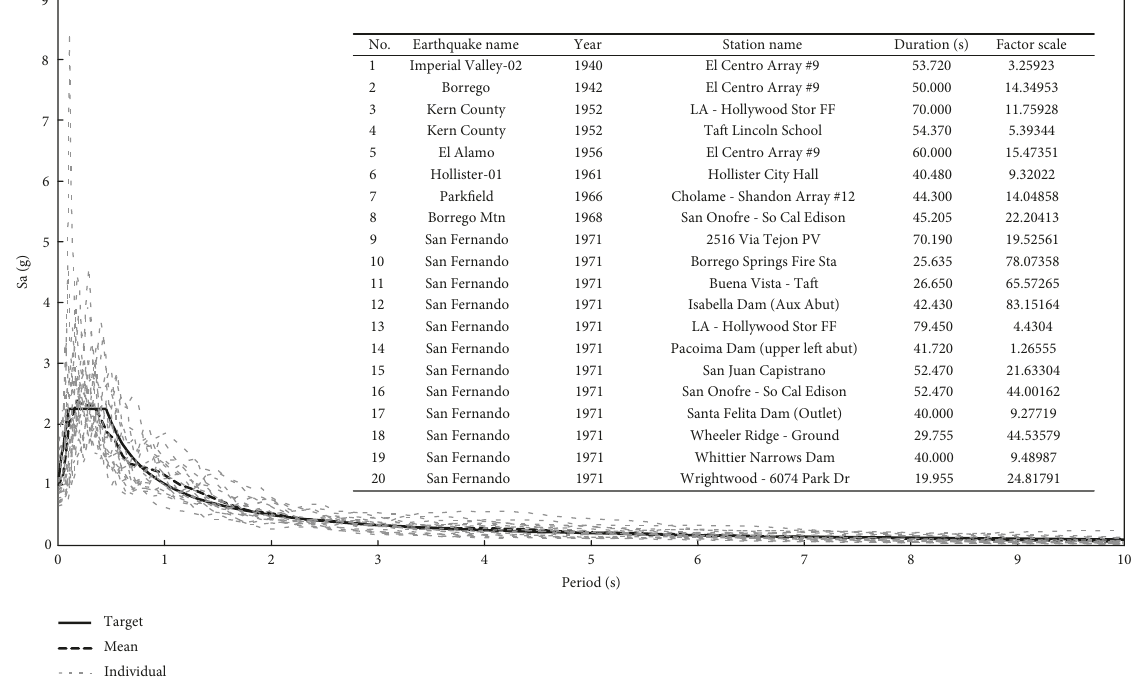
Figure 2: Target spectrum, mean spectrum, and individual earthquake spectra (PGA